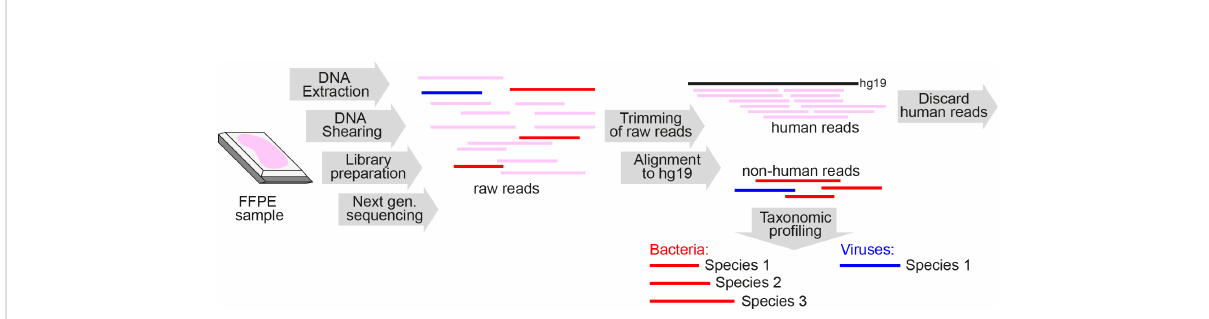
FIGURE 1 Schematic overview of metagenomics analysis of DNA extracted from FFPE tissue samples. FFPE, formalin- fi xed paraf fi n-embedded; Next gen. sequencing, Next-generation